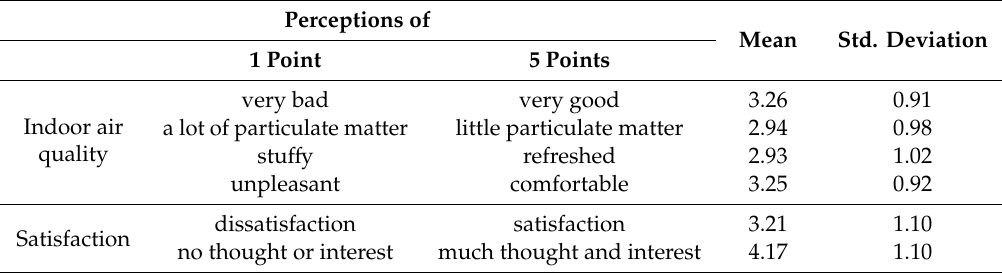
Table 6. Perceptions of and satisfaction with air quality.